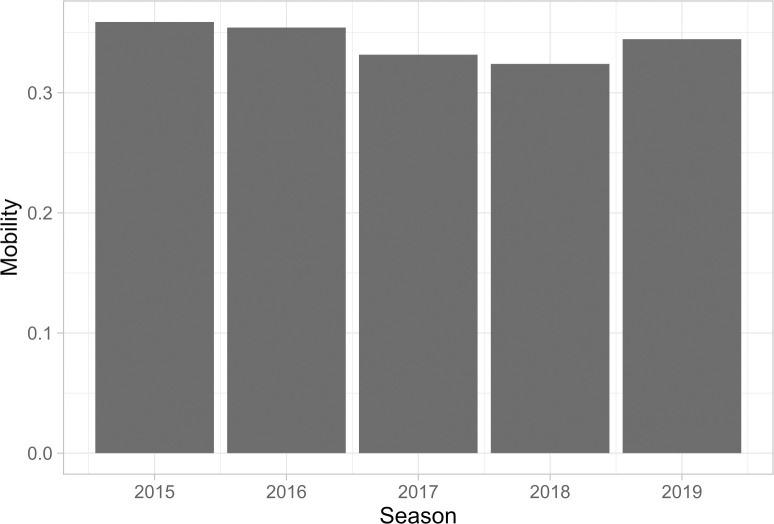
Mobility in the NBA.